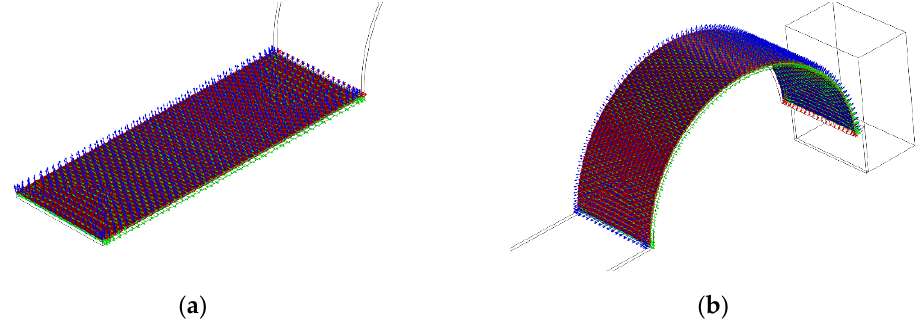
Figure 4. Schematic diagram of material coordinate system: ( a ) straight beam part; ( b ) arc beam